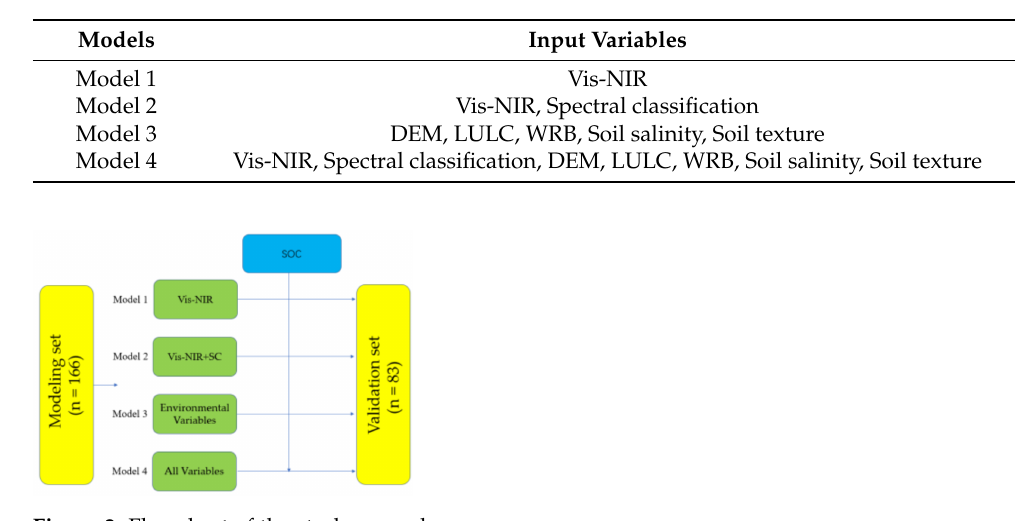
Table 2. Variable sets for each model.